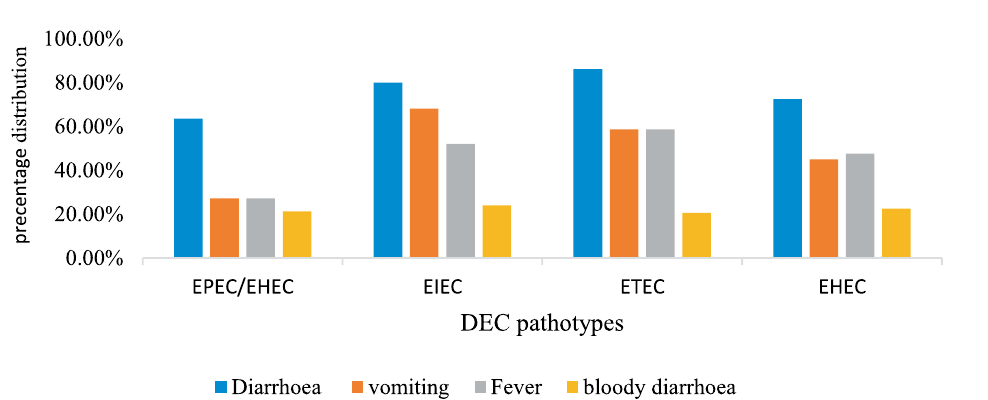
Fig. 1. Distribution of clinical symptoms according to DEC pathotypes